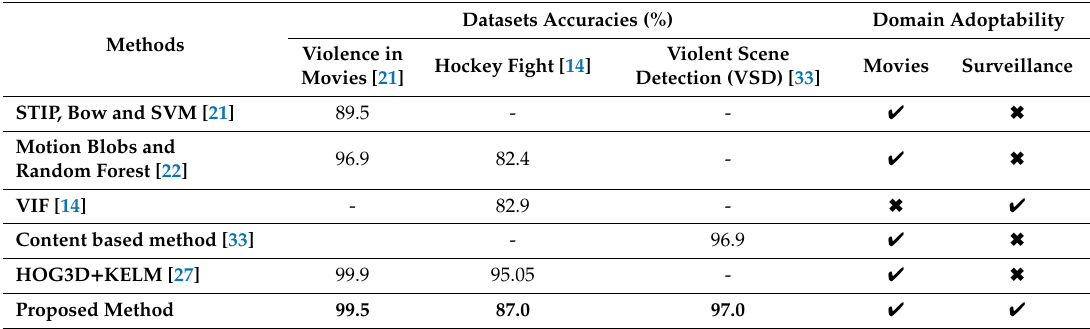
Table 1. Comparison of the proposed method with the state-of-the-art